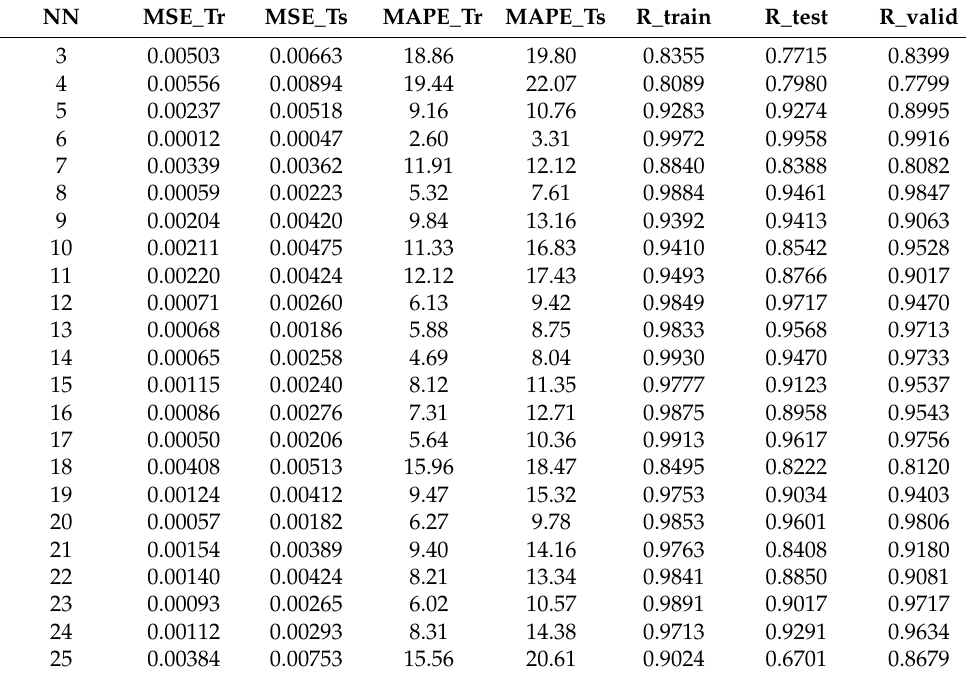
Table 3. ANNs performances for optimised β